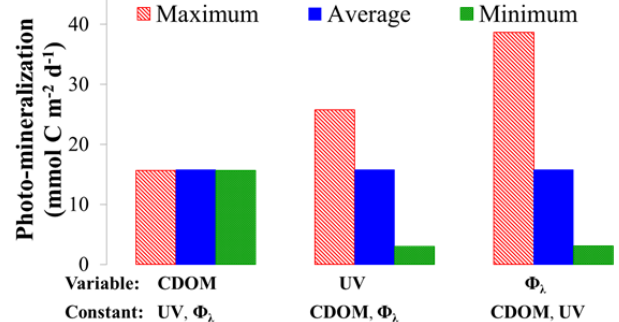
Figure 7. Effect of CDOM, incident UV, and (cid:56) λ (apparent quan- tum yield) on water column rates of photo-mineralization of DOM to CO 2 in Imnavait Creek. For each scenario, two variables from Eq. 3 were held constant, and one was varied using the average, minimum, and maximum values observed over the study period at Imnavait Creek (2011–2012). UV = daily total UV reaching wa- ter surface at Imnavait Creek (dependent on solar zenith angle and cloud